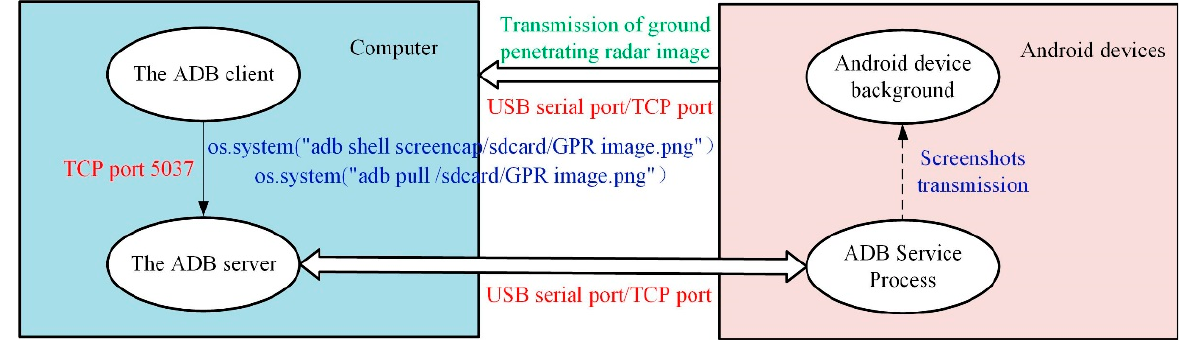
Figure 7. Schematic diagram of real-time acquisition of GPR image.